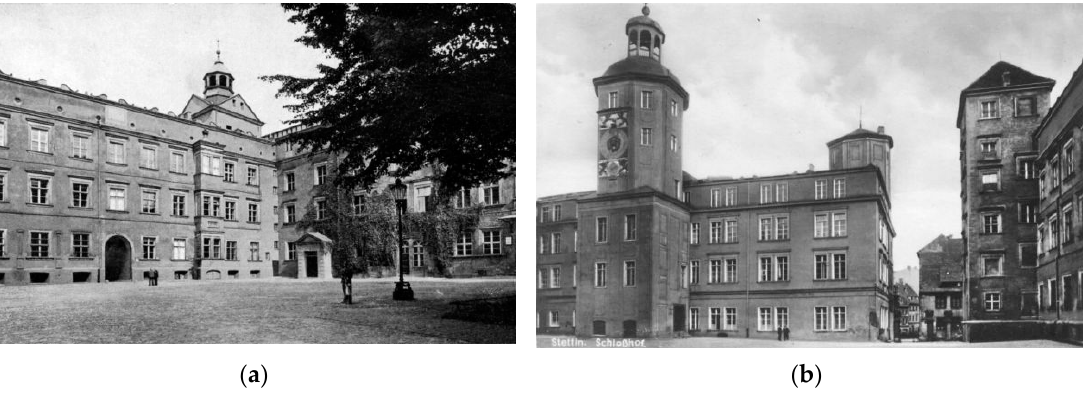
Figure 5. ( a ) Main courtyard after cloister demolition, source: sedina.pl; ( b ) the southern wing after second reconstruction, source: sedina.pl.